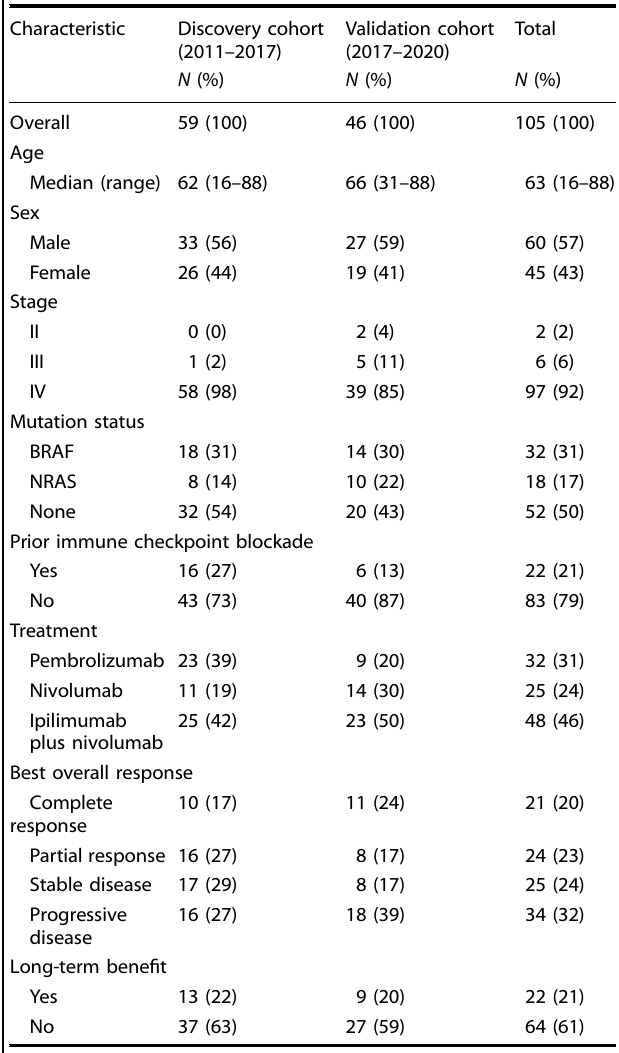
Fig. 1 Study work fl ow. Development of gene signatures that predict LTB to programmed cell death protein 1-based immunotherapies in patients with melanoma. Created with BioRender.com. FFPE formalin- fi xed paraf fi n-embedded, ORR objective response rate, STB short-term bene fi t, LTB long-term bene fi t. Table 1. Patient